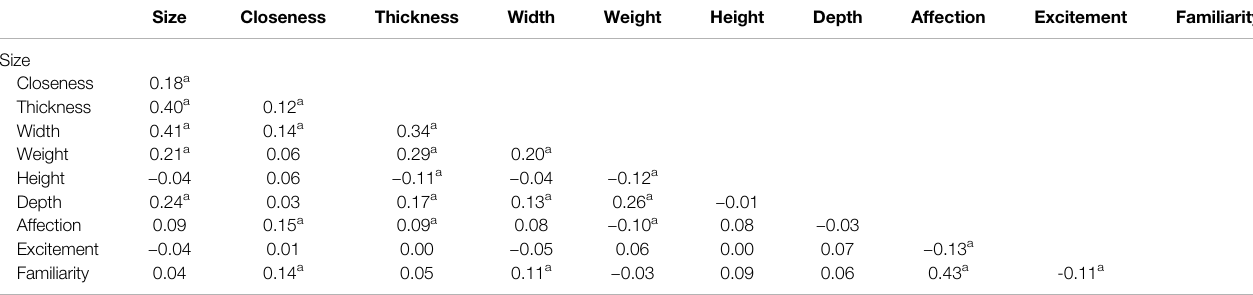
TABLE 2 | Results of Spearman rank correlation analyses among mean scores of each subjective evaluation.